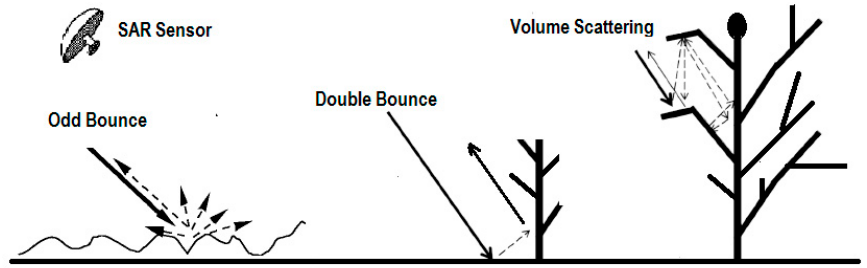
Figure 3. Three surface scattering mechanisms.